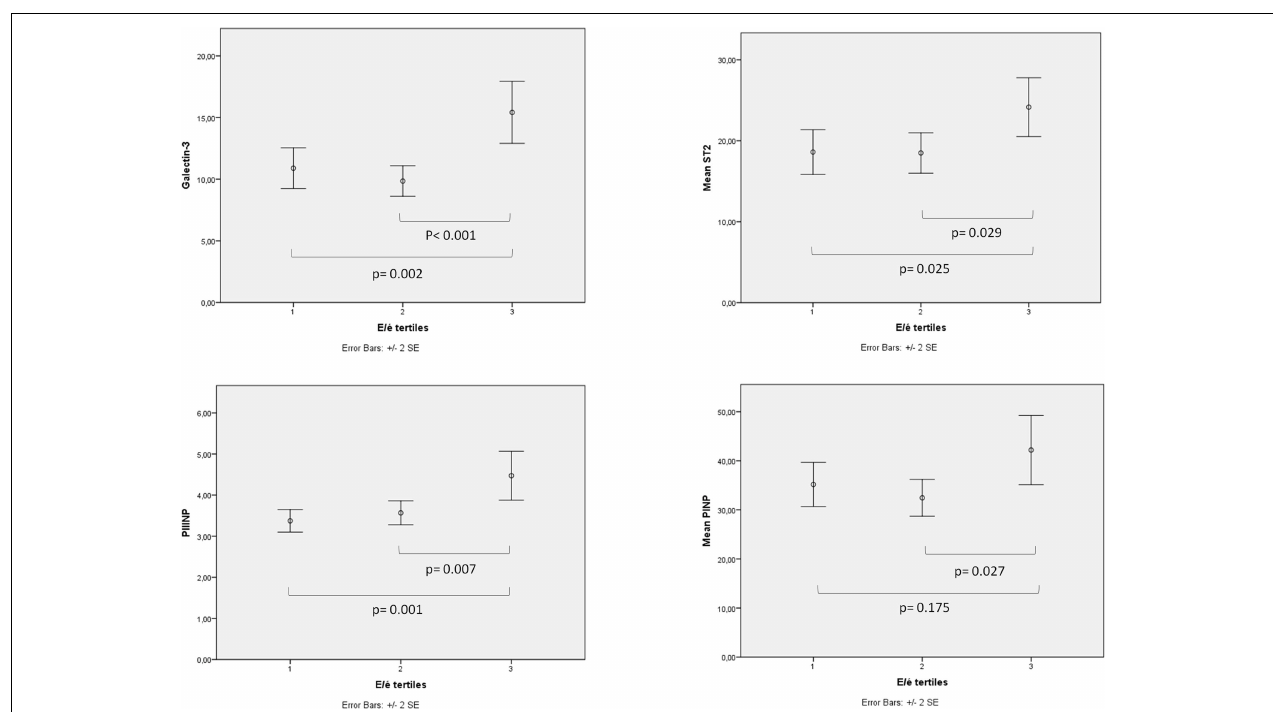
FIGURE 3 | The correlation between diastolic function and biomarkers. When subjects were divided into tertiles according to LV diastolic function (E/é-values) the tertile with the most impaired LV diastolic function had significantly higher serum levels of GAL-3, ST2, and PIIINP compared to the other two tertiles.